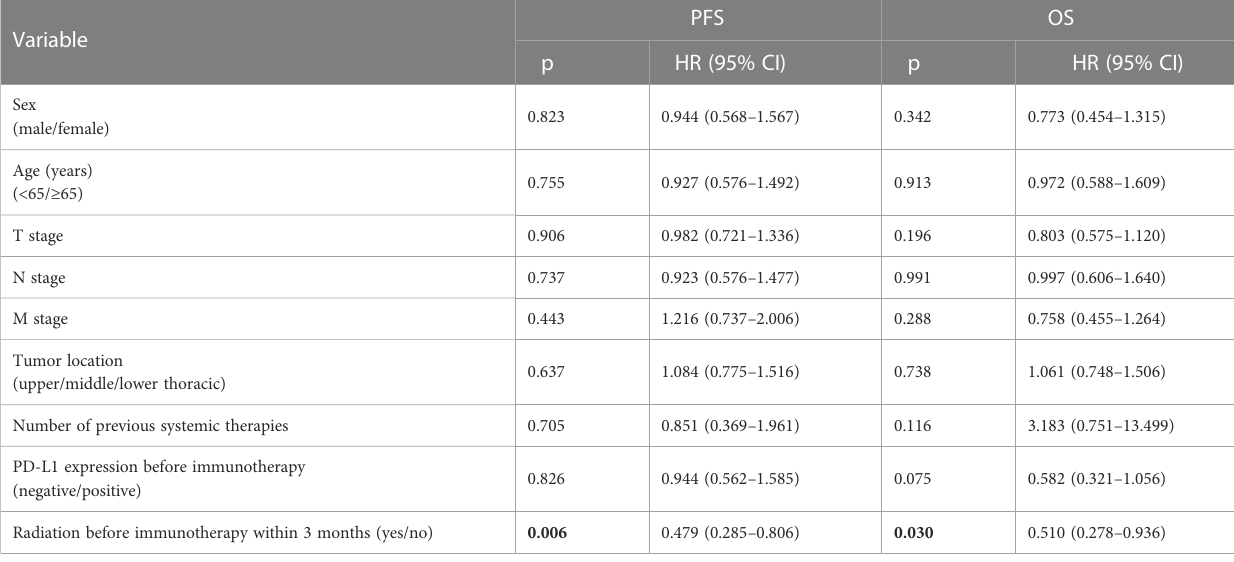
TABLE 2 Cox regression analyses of factors affecting the PFS and OS of ESCC patients (n = 133).